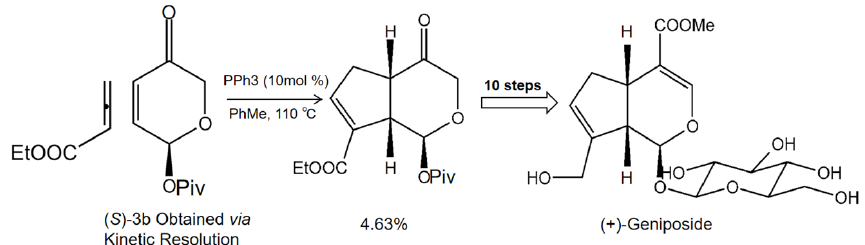
Figure 1. The synthetic method of natural product geniposide. Ethyl 2,3-butadienoate and enone ( S )-3b undergo [3+2] cycloaddition reaction under phosphine catalysis to generate cis-fused ( S )-3b undergo [3 + 2] cycloaddition reaction under phosphine catalysis to generate cis-fused cyclo- penta[c]pyran 4; then, the cis-fused cyclopenta[c]pyran 4 is converted to the natural product iridoid